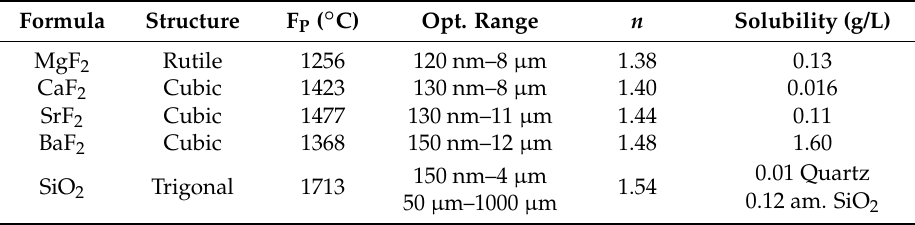
Table 1. Some optical data for selected metal